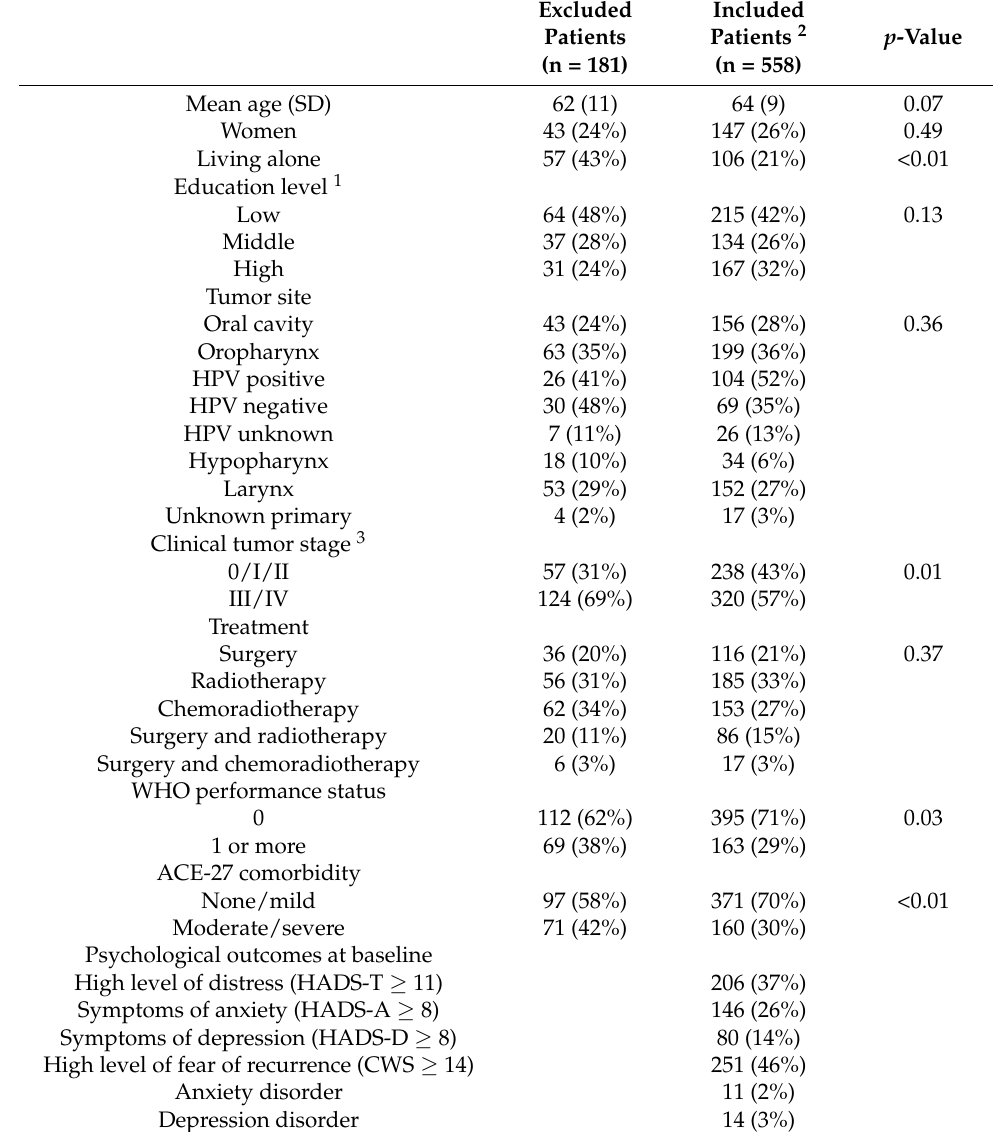
Table 1. Characteristics of included and excluded